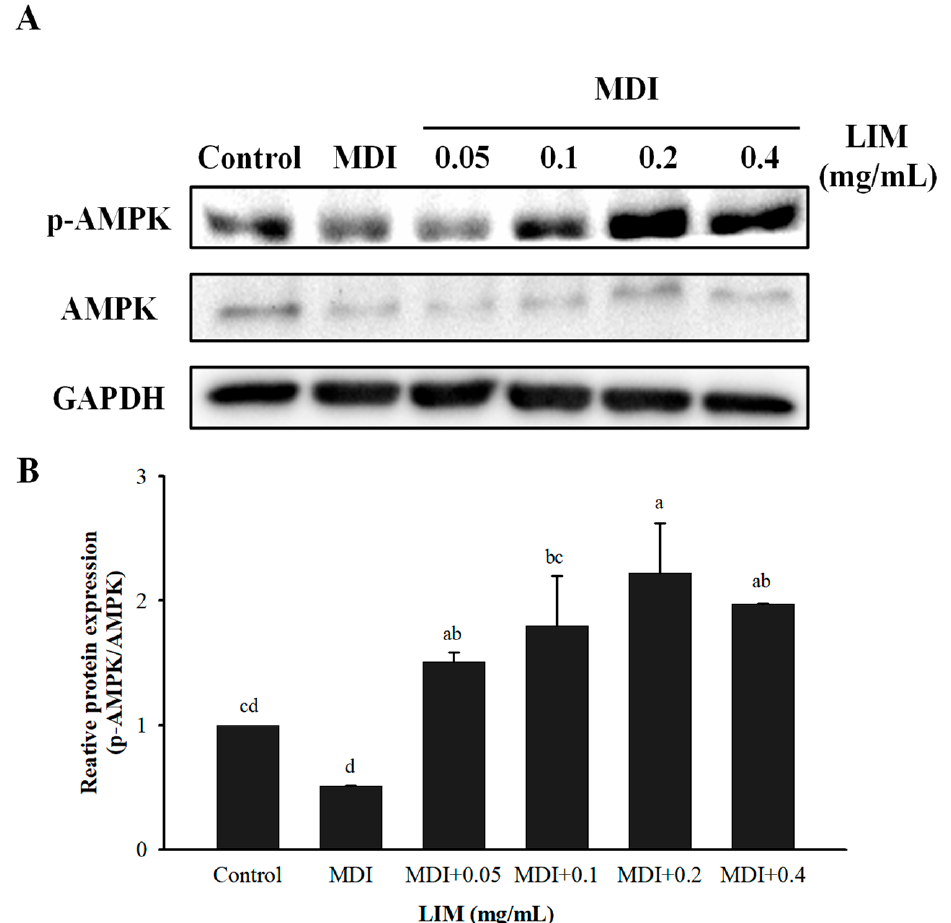
Figure 3. Effect of limonene (LIM) on protein expression of p-AMPK/AMPK in 3T3-L1 adipocytes. ( A ) Representative Western blot image showing the p-AMPK (62 kDa), AMPK (62 kDa), and GAPDH (37 kDa). ( B ) The graph shows the densitometric analysis of the p-AMPK/AMPK. The histogram showed the relative fold change compared with the control group. The significant difference was evaluated by Tukey’s test for lipid accumulation. Data were the means ± SD ( n = 3). The values represented by different alphabets (a–d) were considered statistically significant between the different groups ( p < 0.05). The differentiation medium (MDI) (containing DMEM supplemented with IBMX (0.5 mM), dexamethasone (1 µ M), and insulin (10 µ g/mL)); AMP-activated protein kinase (AMPK).